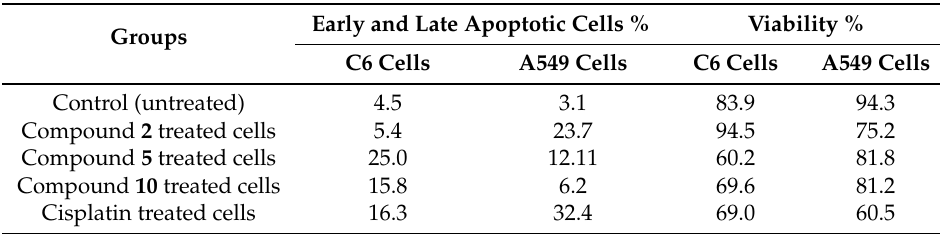
Table 2. The percents of typical quadrant analysis of annexin V-FITC/propidium iodide flow cytometry of A549 and C6 cells treated with the